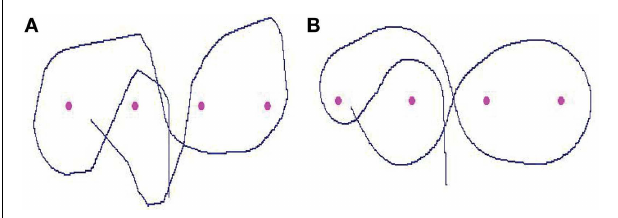
FIGURE 5 | (A) Representation of a sharp trajectory carried out by the robot during the slalom task between the four landmarks.This sharp pattern – related to the stops that happen before the main changes in the steering trajectory – is characteristic of a situation in which the camera is maintained fixed, pointing in the same direction of the vehicle’s axis. (B) Representation of a smooth (or curvilinear) trajectory carried out by the robot during the slalom task between the landmarks.This uniformly smoothed pattern is a typical example of a condition in which the camera visually anticipates the platform displacement.